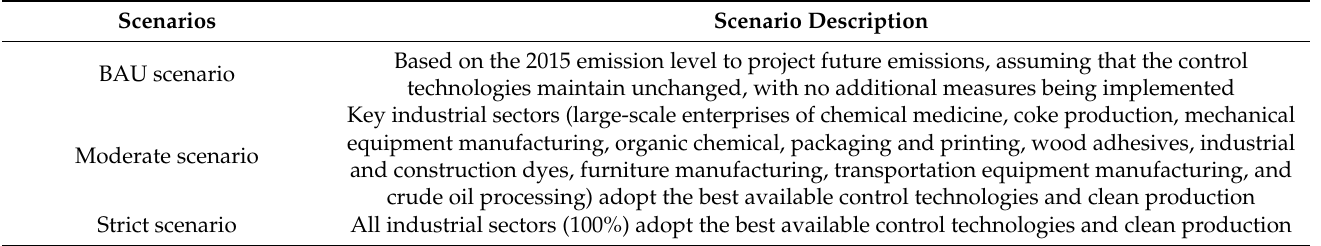
Table 4. Specific descriptions of the three scenarios designed in this paper.